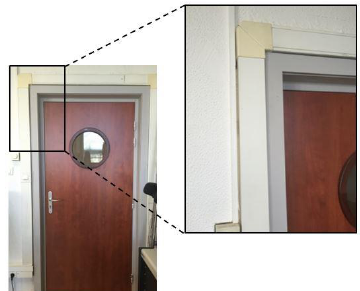
Figure 15. Comparison of a section realized on the created mesh (dark blue) and a true section (green). Figure 16. Example of a specific case where the cable